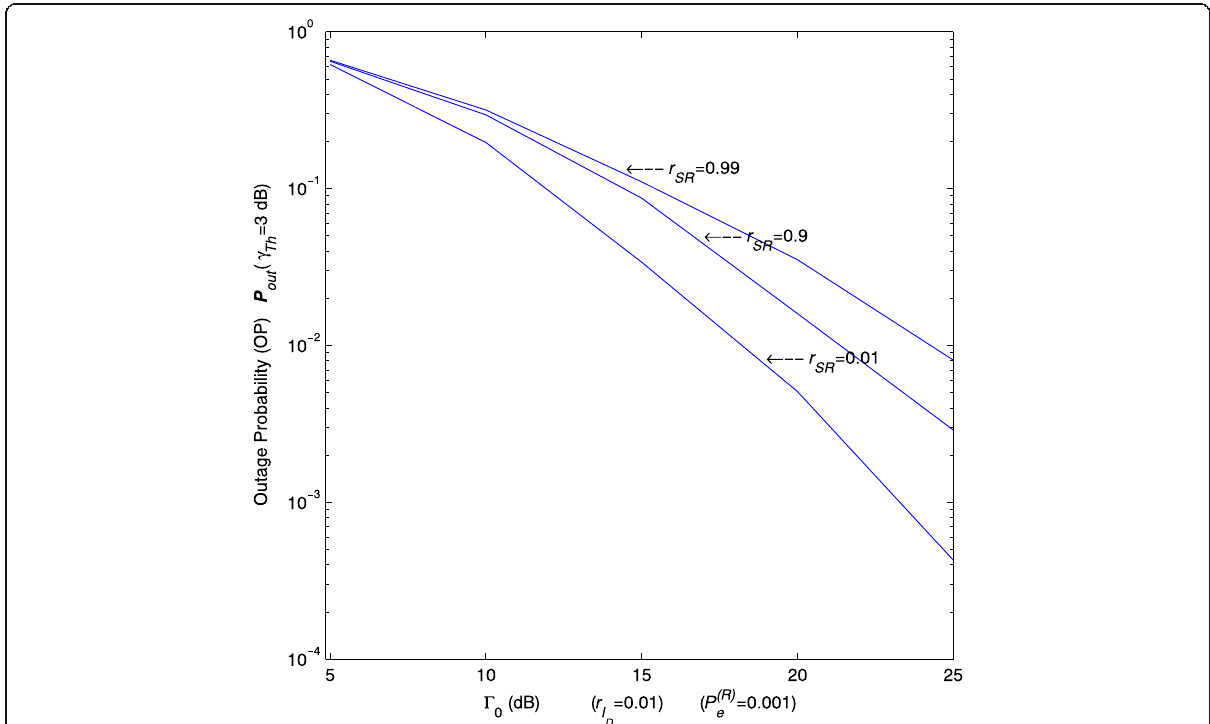
¼ 0 : 01), and thermal noise, with N D